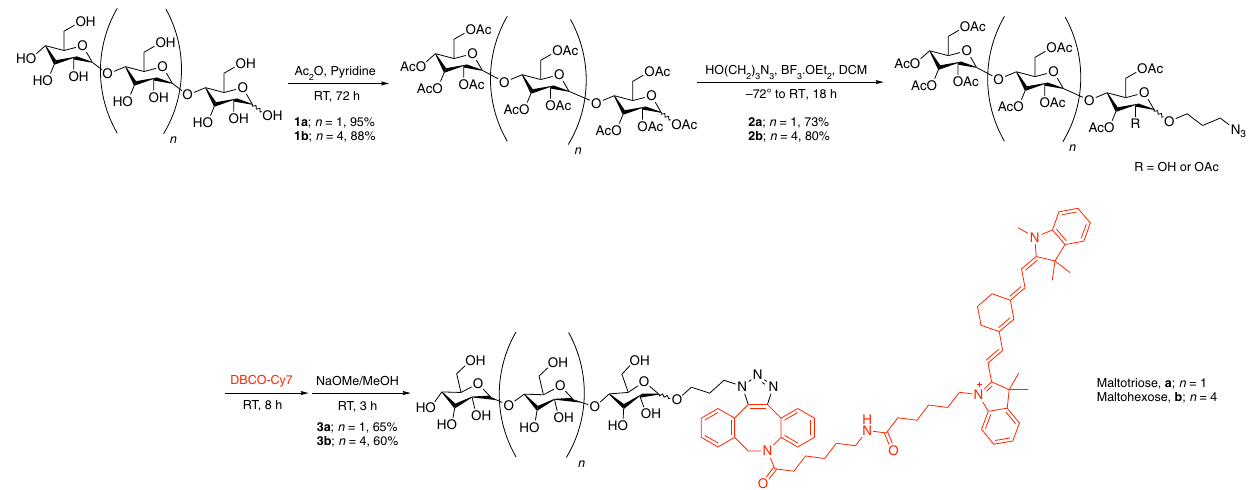
Fig. 1 Synthesis of Cy7-1-maltotriose and Cy7-1-maltohexose. DBCO dibenzoyl cyclooctyne, RT room temperature, Me CH 3 , Et CH 3 CH 2 , DCM